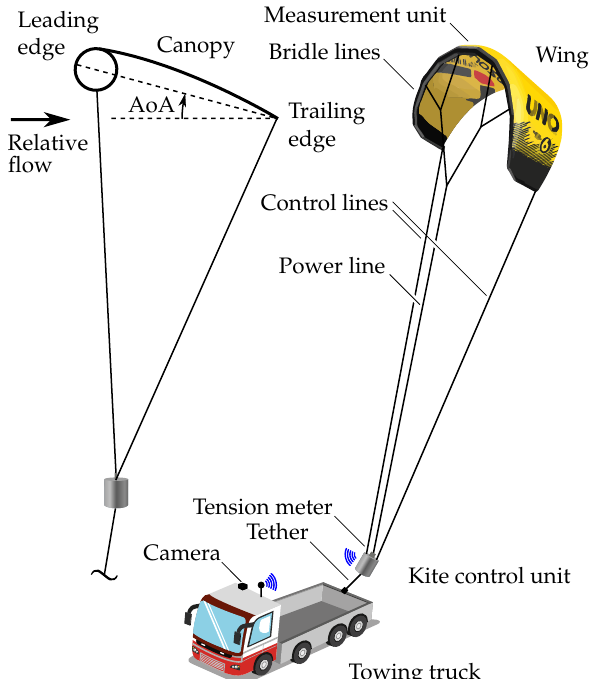
Figure 5. Schematic illustration of the tow test setup: side view with angle of attack (AoA) definition ( left ) and 3D view ( right